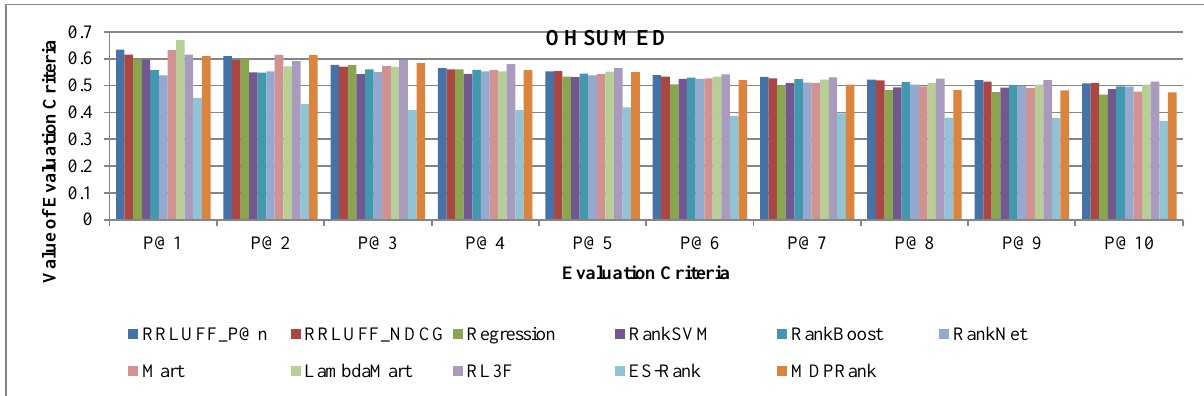
Figure 5. Comparison between the proposed algorithm and algorithms expressed regarding the evaluation criterion MAP.